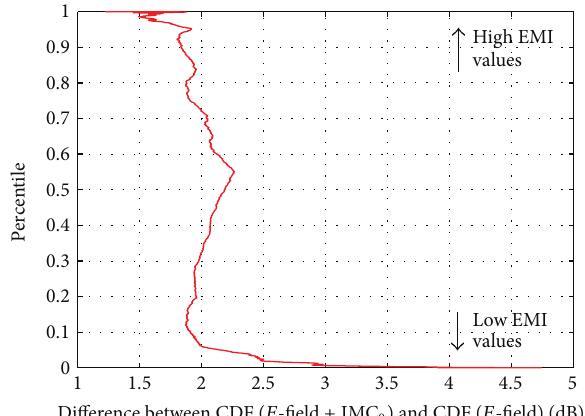
Figure 17: Difference in dB between the CDFs of the radiated EMI before and after applying the EMC Friendly Power